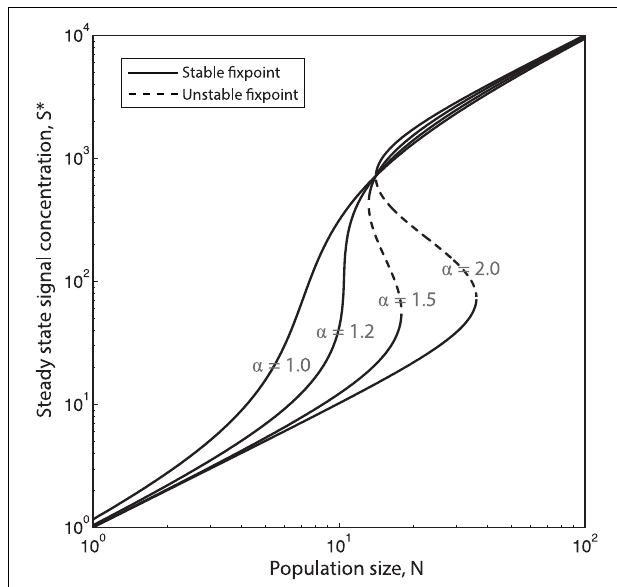
FIGURE 4 | Increasing the QS signal feedback exponent α causes hysteretic response to population changes. Steady state QS signal concentration, S * as function of the population size N , plotted for four different values of the QS feedback exponent α = [ 1 . 0 , 1 . 2 , 1 . 5 , 2 . 0 ] . When 2 + σ max s + 2 1 + σ max s α > α c = q σ max